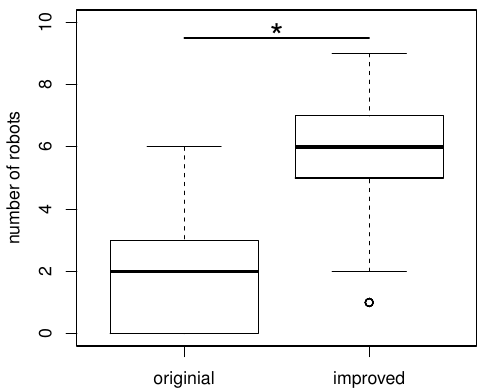
Figure 8: Comparison between the performance of both BEECLUST implementations in terms of the number of stopped robots in zone I during the last ten minutes time interval in the one dimmed light